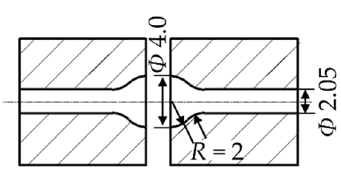
Figure 12. Schematic of the die cavity shape used for the evaluation of the fracture and bursting limit of the tube.